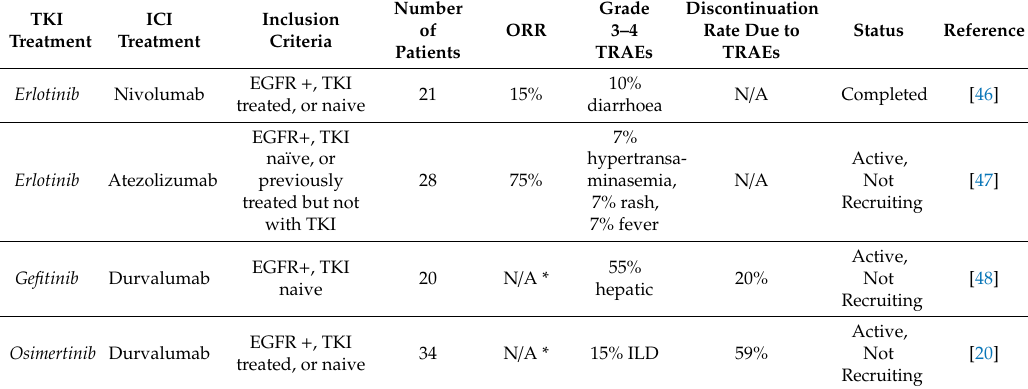
Table 2. Studies of ICIs combined with